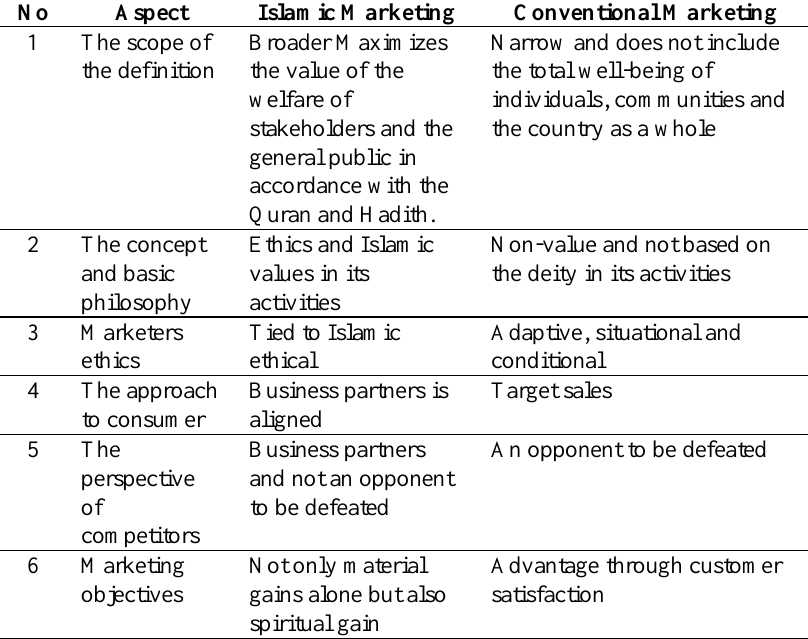
Table 2 The differences between Islamic marketing and conventional